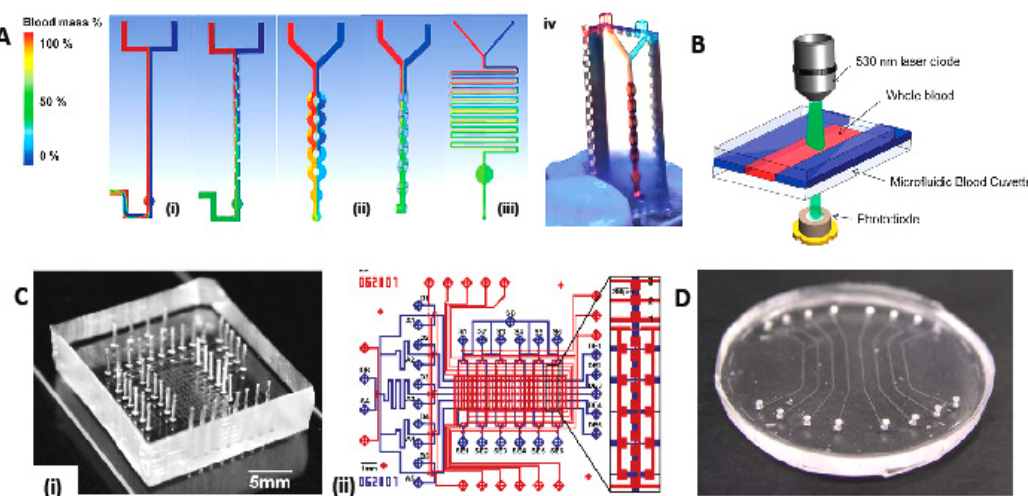
Figure 1. ( A ) Design of three sophisticated POC system iPOC 3D microfluidic mixers simulated by 3D computational fluid dynamics: ( i ) Split-and-recombine (SAR) mixing, ( ii ) ring-shaped channel, and ( iii ) serpentine channel. Red flow is blood mixed with an aqueous solution (blue); green indicates complete mixing. ( iv ) Image of 3D printed, 3D-structured micro-mixer showing efficient mixing within 1 s using colored dye solutions [25]. ( B ) Setup for measuring hemoglobin concentration [26]. ( C ) Microfluidic immunoassay chip from Kartalov's group. ( i ) The experiment used this 60-chamber polydimethylsiloxane (PDMS) chip bound to a 1-inch-wide epoxide slide. ( ii ) Architectural diagram of the test column [30]. ( D ) Eight-channel PDMS microfluidic device for ferritin immunoassay detection demonstrated by Schrott et al. [32].